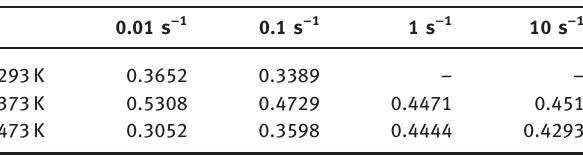
Table 13: f 3 ð _ ε , T Þ value under low temperature range with different strain